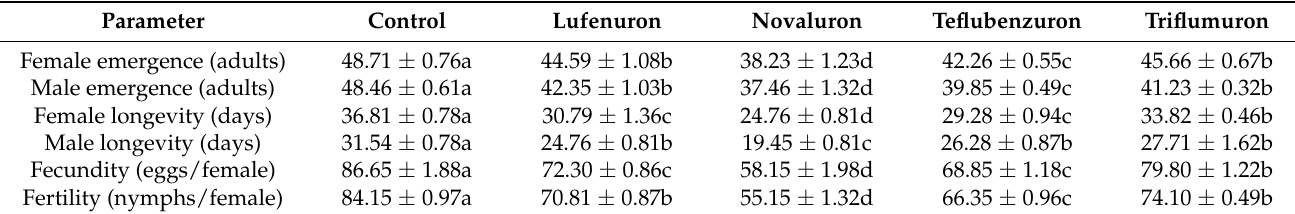
Table 2. Effects on the emergence, longevity, and reproduction of Leptopharsa gibbicarina caused by sublethal concentration (LC 25 ) of the four BPUs. In the table, values followed with the same letter in the row do not differ significantly, according to the Tukey’s honest significance difference (HSD) test ( p < 0.05).